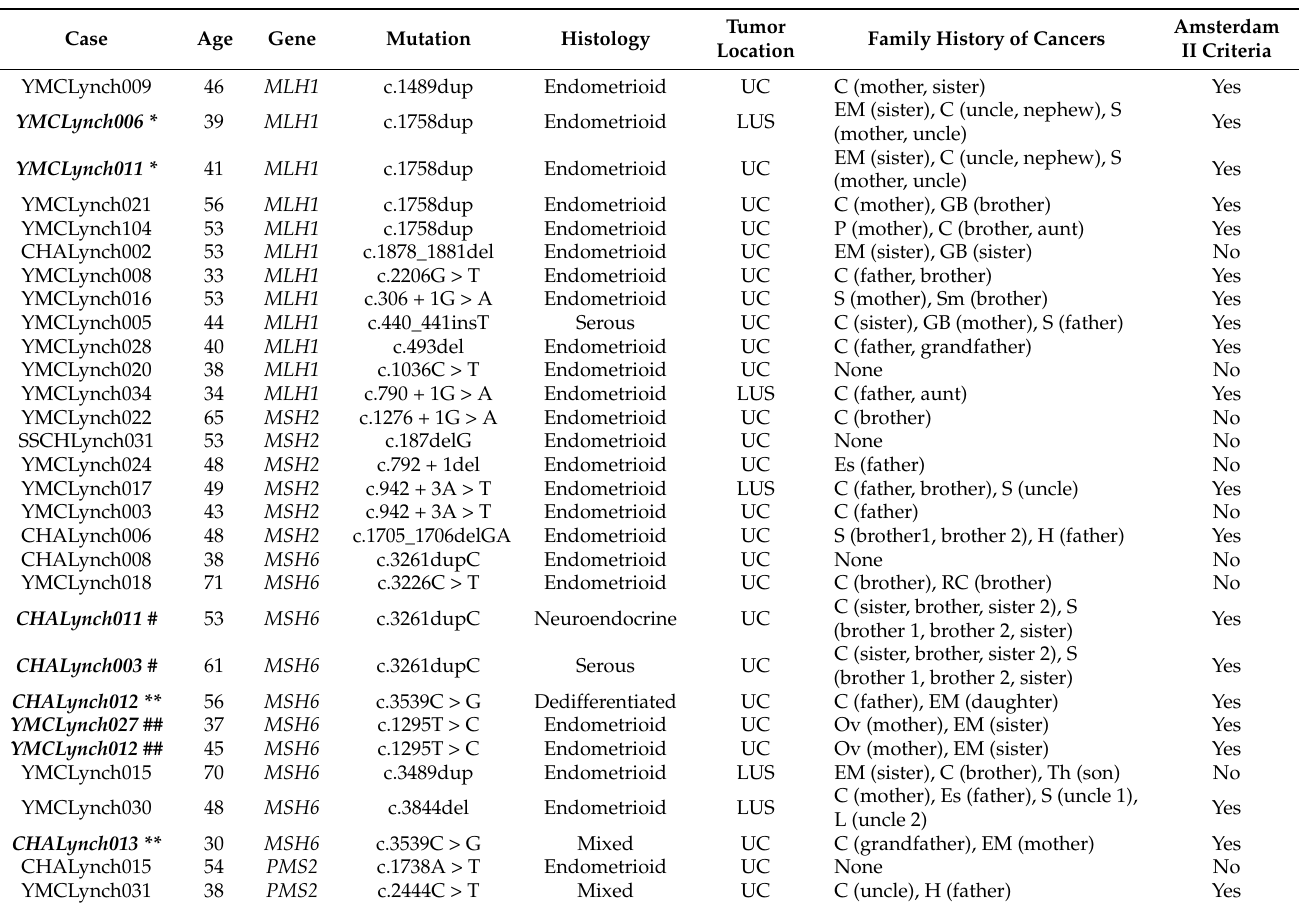
Table 2. Detailed information of MMR gene germline pathogenic or likely pathogenic variants in endometrial cancer (n = 30).